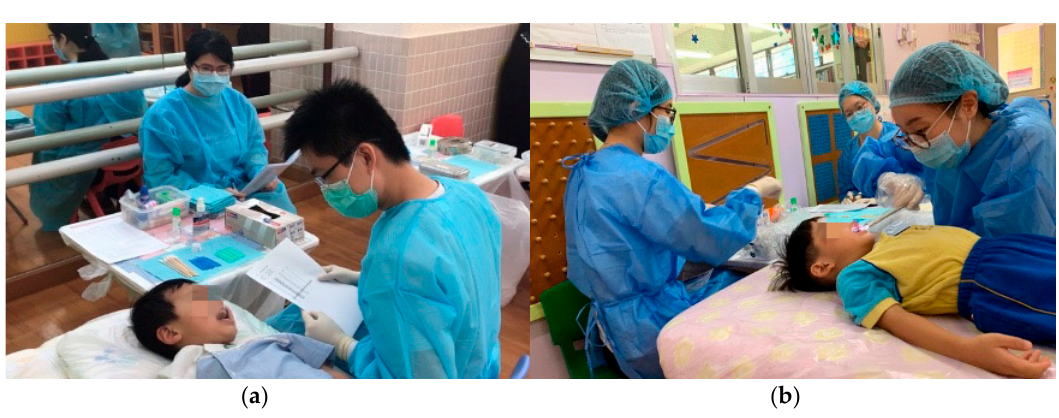
Figure 5. Dental service for children. ( a ) Re-checking a child’s name prior to examination; ( b ) dental examination at a kindergarten.